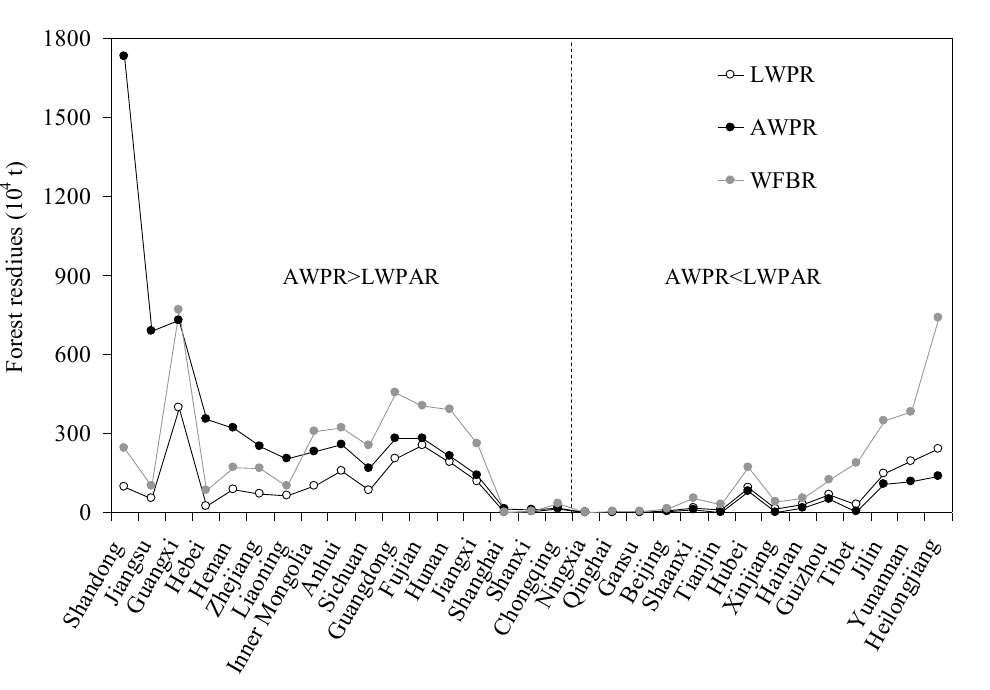
Figure 6. Comparisons of the wood processing residue (WPR) based on actual processing and assumed local processing in different